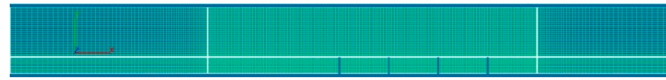
Figure 4. The plan view of the computational